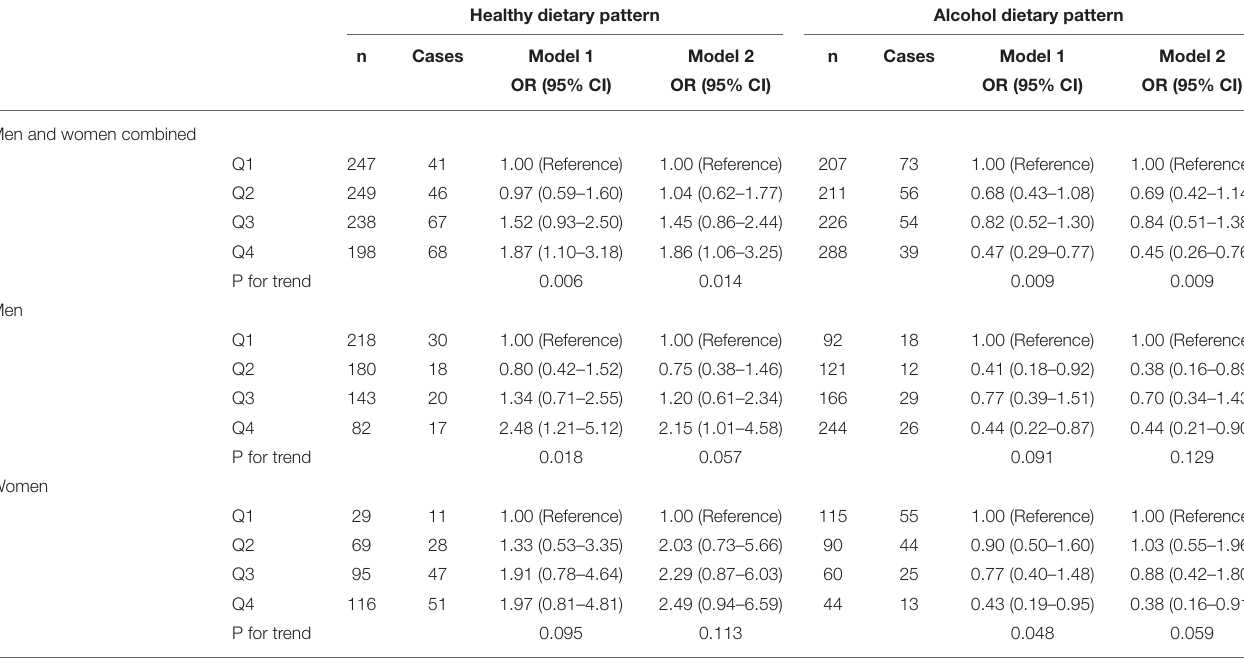
TABLE 5 | Odds ratios and 95% confidence intervals for the prevalence of the MHO phenotype according to dietary pattern score quartile in the obese group. Healthy dietary